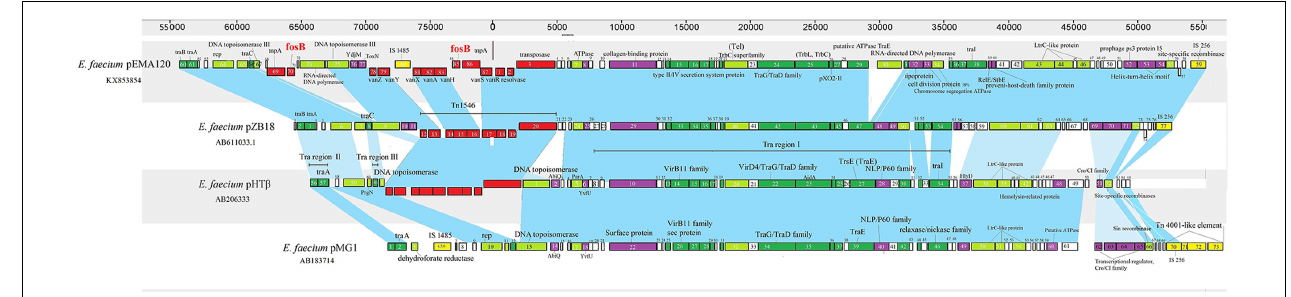
FIGURE 3 | Comparison of E. faecium plasmid pEMA120 and three reported E. faecium plasmids pZB18, pHT β , pMG1. Light blue shades indicate shared regions with a high degree of homology. ORFs are portrayed by rectangles and colored according to their putative functions. Light-green rectangles indicate genes associated with replication, recombination and repair. Genes associated with plasmid conjugal transfers are colored in green. Genes involved in plasmid stability are indicated by purple. Red and yellow rectangles indicate antimicrobial resistance genes and mobile elements genes, respectively. White rectangles indicate genes for hypothetical proteins as well as proteins of unknown